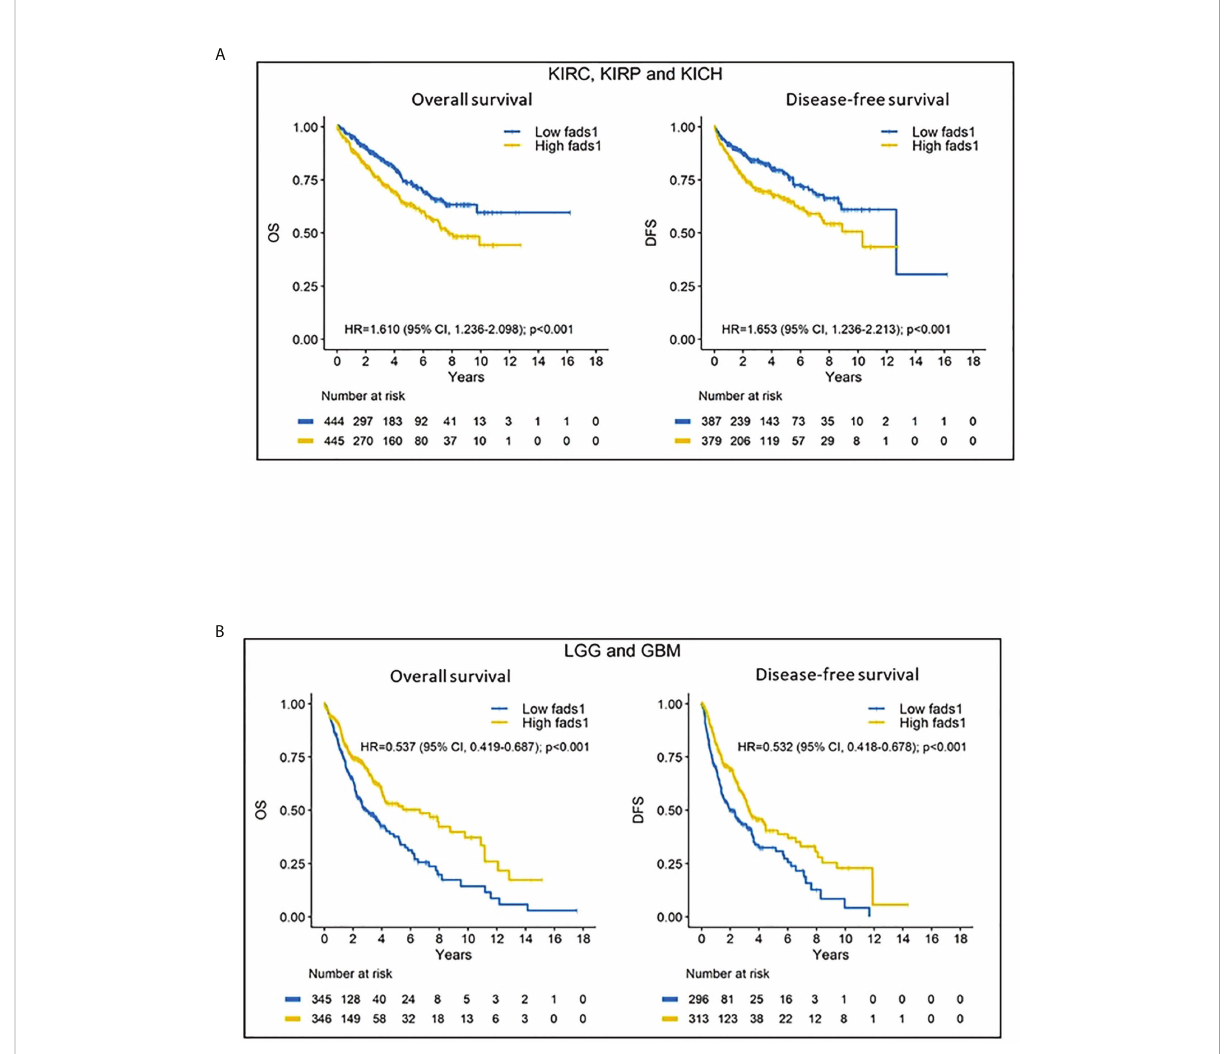
FIGURE 2 (A) Kaplan-Meier (KM) curves of kidney cancers. Kidney cancer patients ’ overall survival and disease-free survival according to their FADS1 expression status. (B) Kaplan-Meier (KM) curves of brain cancers. Brain cancer patients ’ overall survival and disease-free survival according to their FADS1 expression